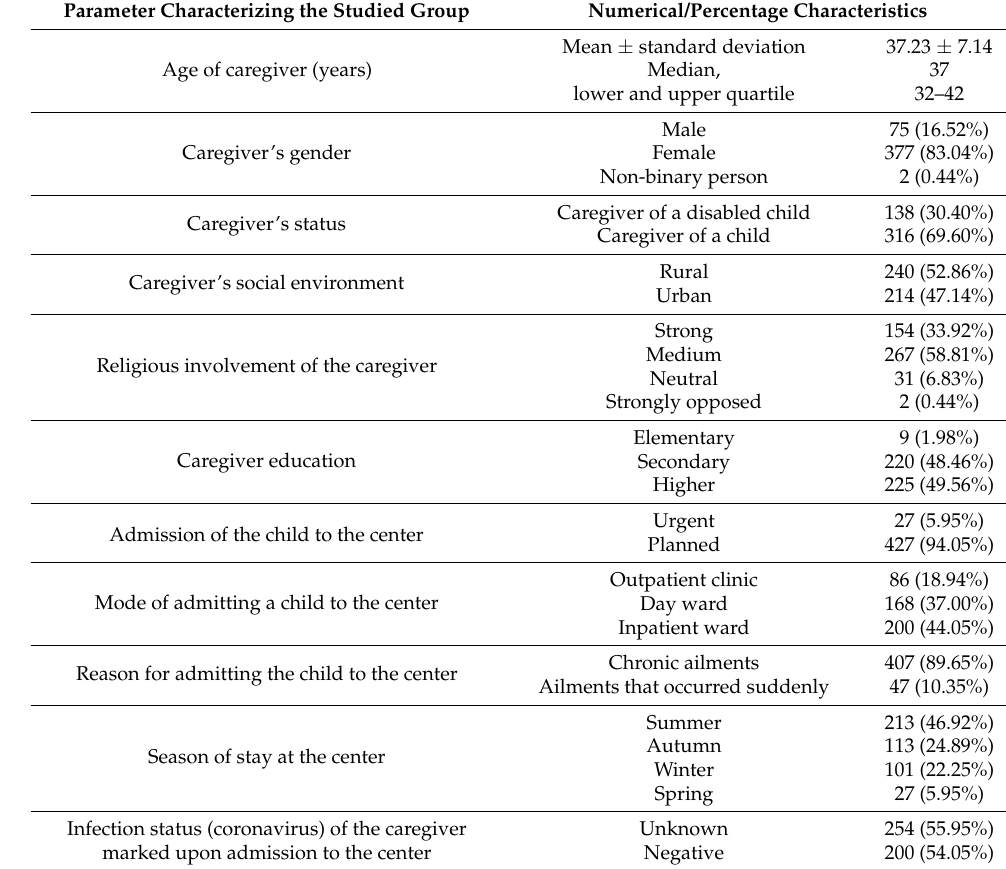
Table 1. Characteristics of the studied